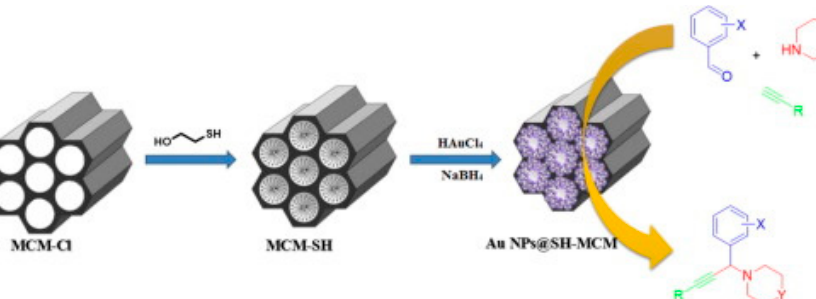
Figure 48. Schematic representation of A3 coupling supported in Au-SH/MCM-41. Reproduced with permission from [91]. Copyright 2015 Elsevier B.V.